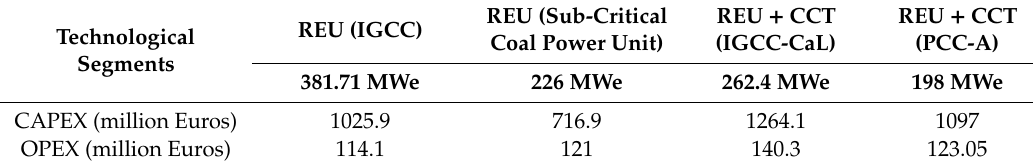
Table 7. Capital expenditures (CAPEX) and OPEX for REUs without and with carbon capture technology (CCT) systems